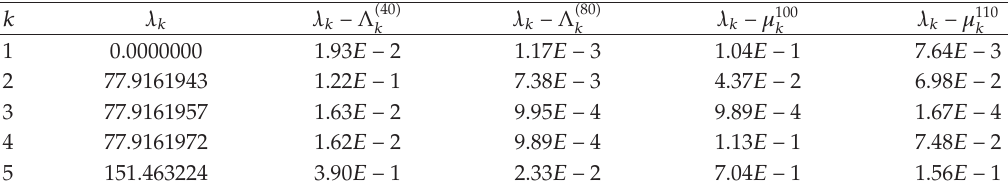
Table 8: Comparison of the exact eigenvalues with approximate eigenvalues obtained from Numerov’s method (cid:2)Λ k (cid:3) with correction and TDM (cid:2) μ k (cid:3) for Example 3.3 corresponding to β (cid:5)